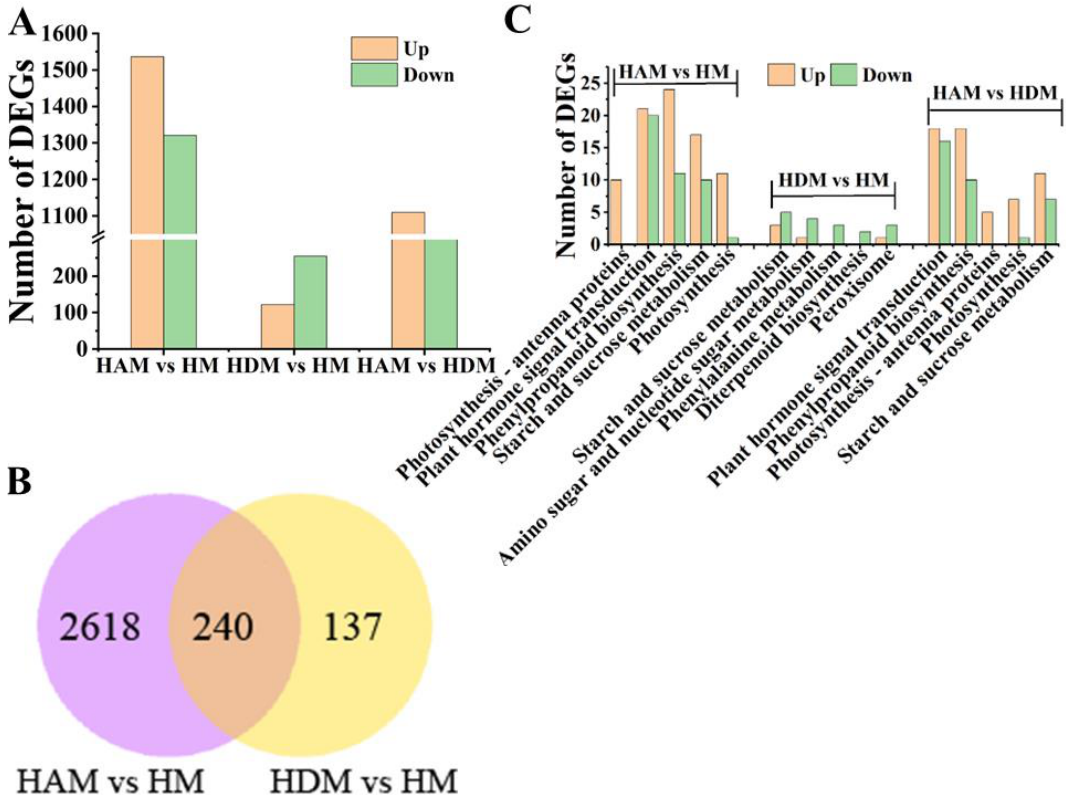
Figure 4. Overview of transcriptomics changes of different comparisons affected by interstocks. ( A ) DEGs in three comparisons. ( B ) Venn diagram of DEG numbers in different comparison groups. The number on the left of the red arrow indicates upregulated gene number, and the number on the left of the green arrow indicates downregulated gene number. ( C ) KEGG analysis (top 5) in three